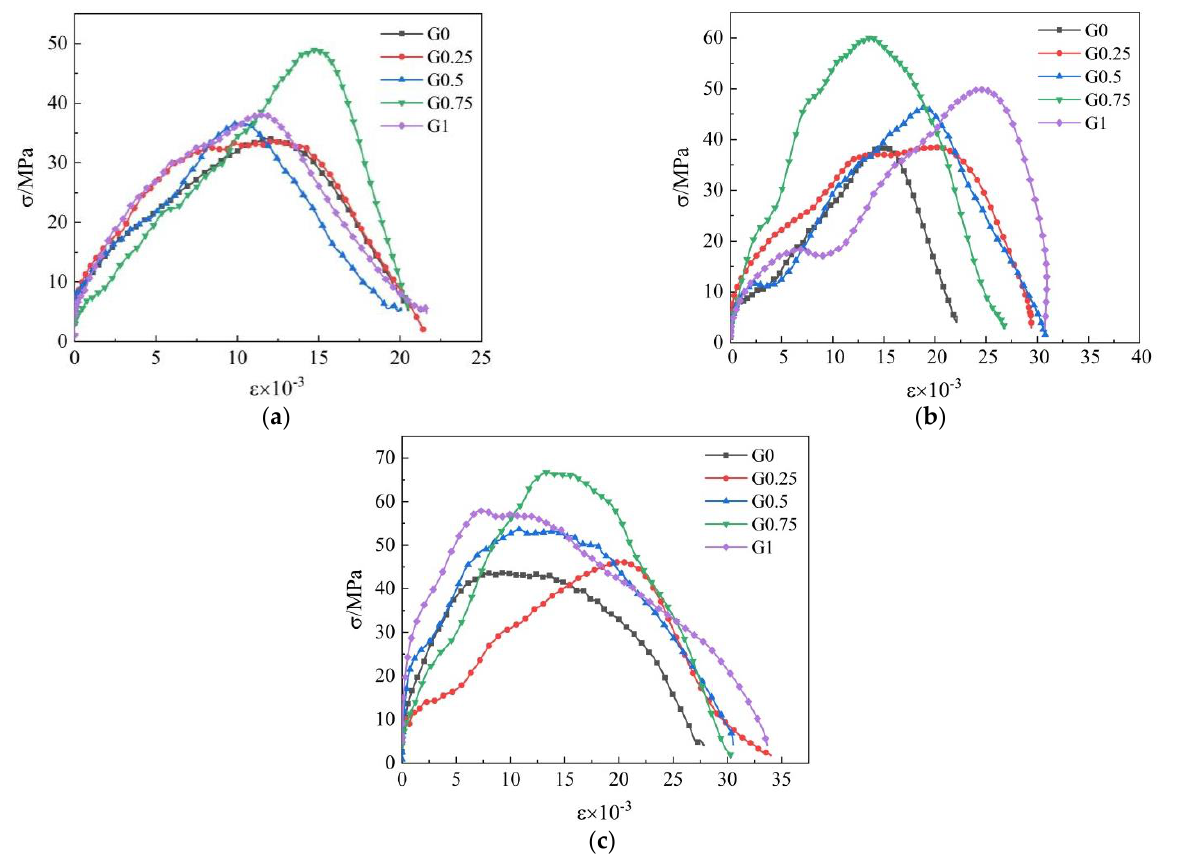
Figure 4. Mortar stress-strain curve under three loading ranges of average strain rate: ( a ) 75.03~94.01 s −1 ; ( b ) 100.27~111.68 s −1 ; ( c ) 134.11~141.47 s −1 .